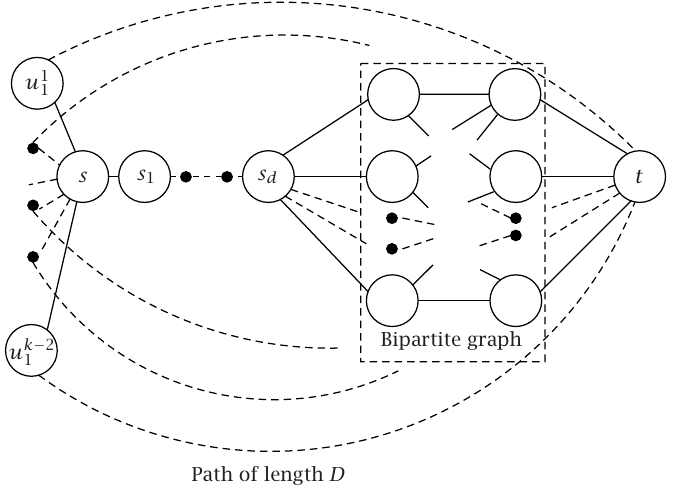
Figure 4.1 . Graph G (cid:5)(cid:5) constructed from bipartite graph G .